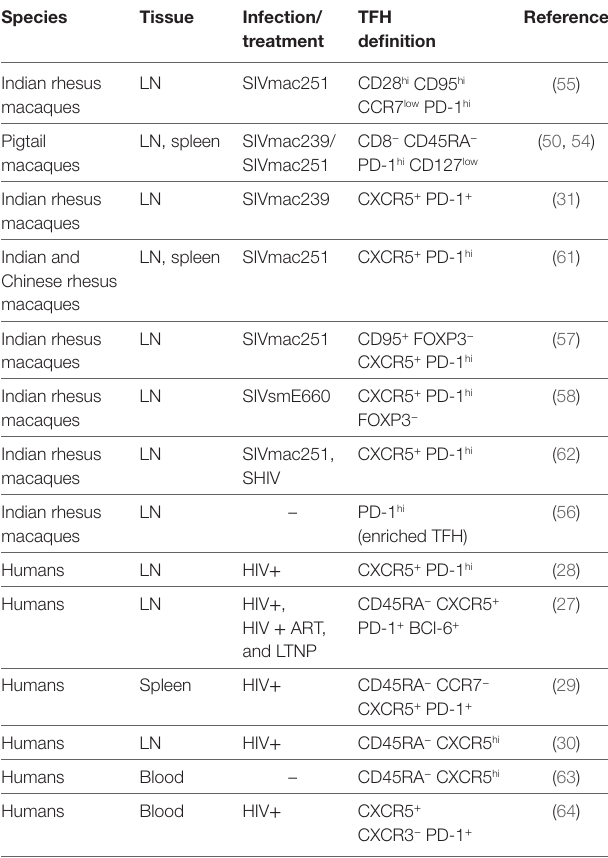
TabLe 1 | Markers to define TFH cells in cell suspension in humans and macaques. Species